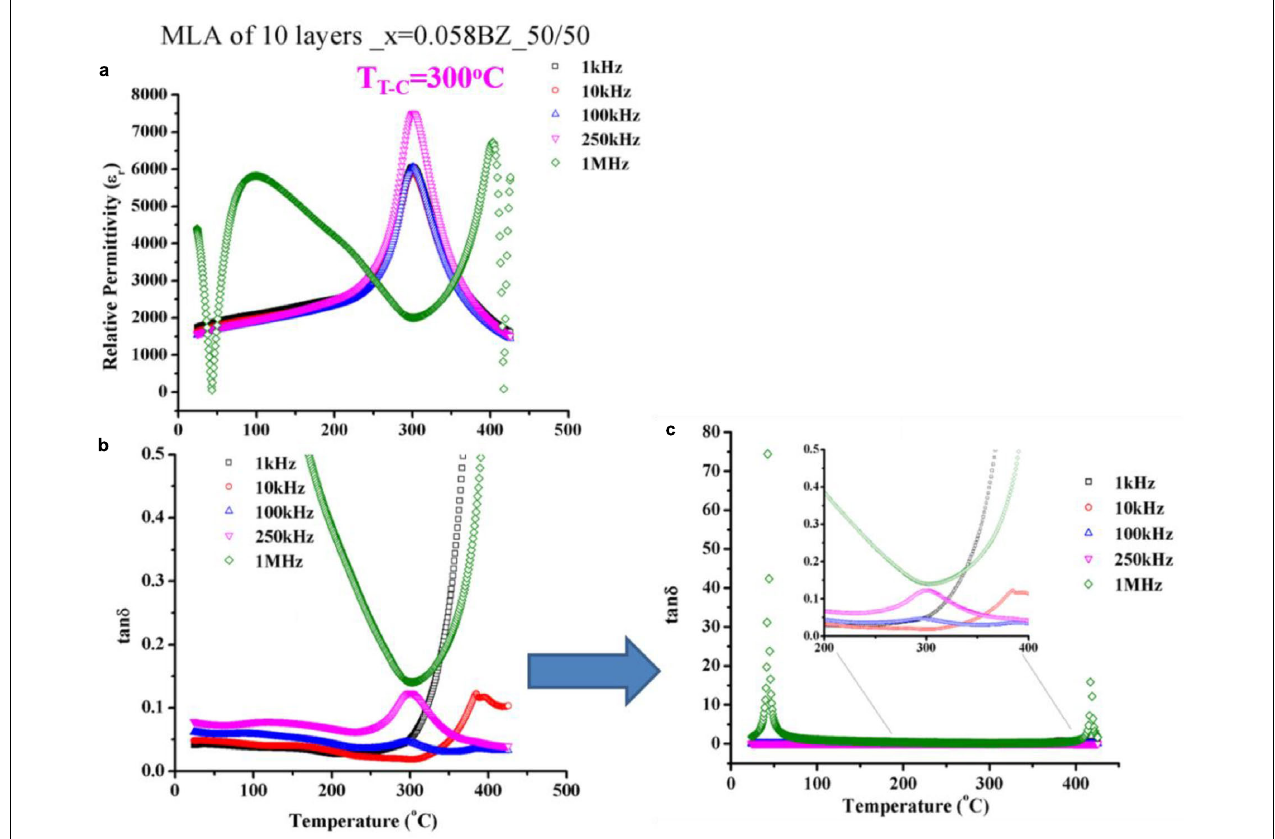
FIGURE 6 | MLA of 10-layers made of commercial grade raw materials of 0.942KNN-0.058BNZ formulation showing (a) relative permittivity, (b) tan δ loss, and (c) tan δ loss of 1 MHz with complete